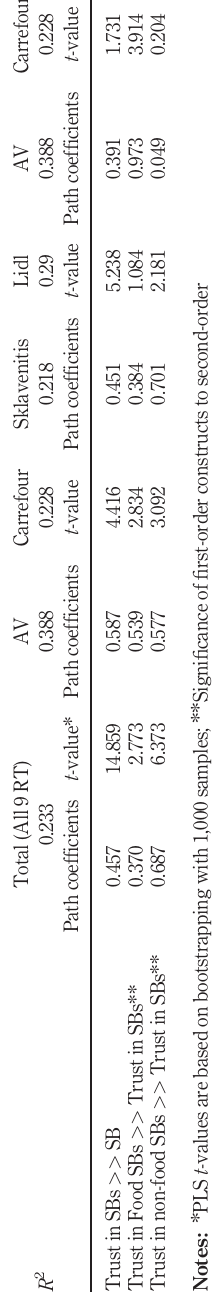
Table II. Structural model